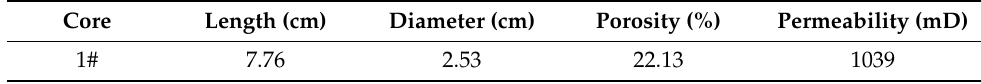
Table 1. Basic parameters of the artificial sandstone cores.